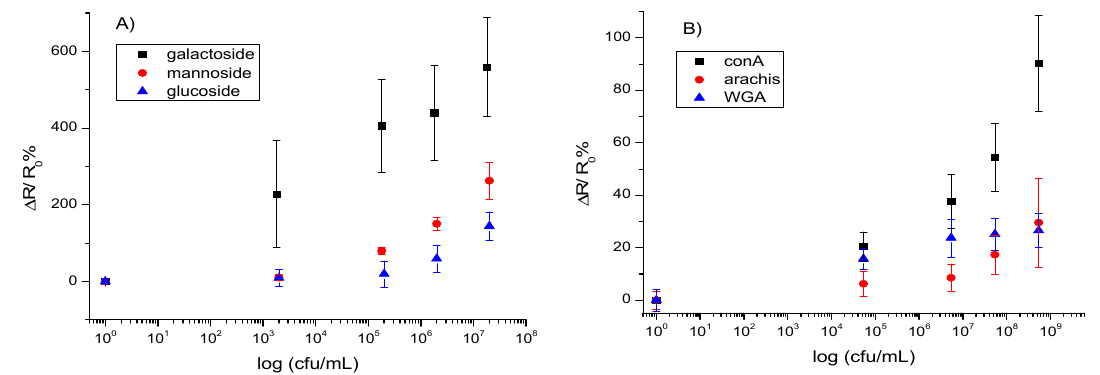
Figure 5. Calibration curves for the detection of ( A ) E. coli via saccharide-modified CNT-devices and ( B ) Streptococcus mutans via lectin-modified CNT-devices. The data points are average measurements from 10 independent biosensors, and error bars represent one standard deviation.